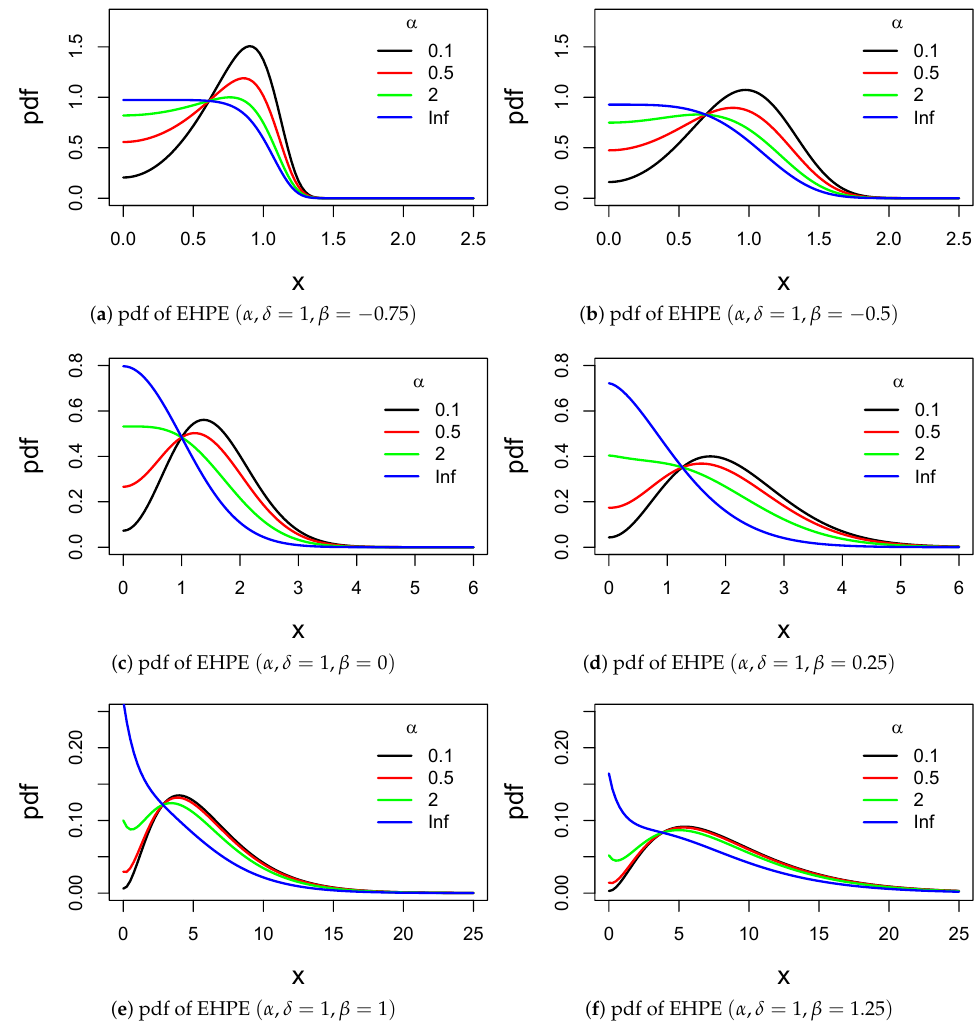
Figure 2. EHPE ( α ,1, β ) pdf’s for different values of α and β . In all panels, α = 0.1 (black), α = 0.5 (red), α = 2 (green), and α = ∞ (blue). As for β value: ( a ) β = − 0.75, ( b ) β = − 0.5, ( c ) β = 0, ( d ) β = 0.25, ( e ) β = 1, and ( f ) β =